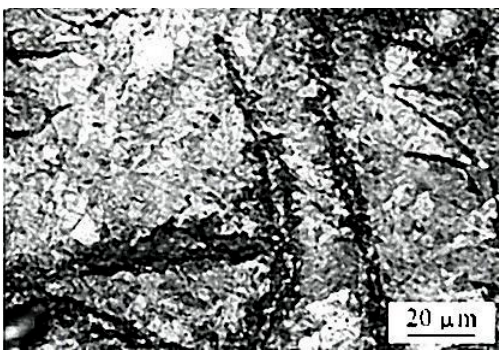
Figure 3. Metallographic structure after the thermal fatigue test.